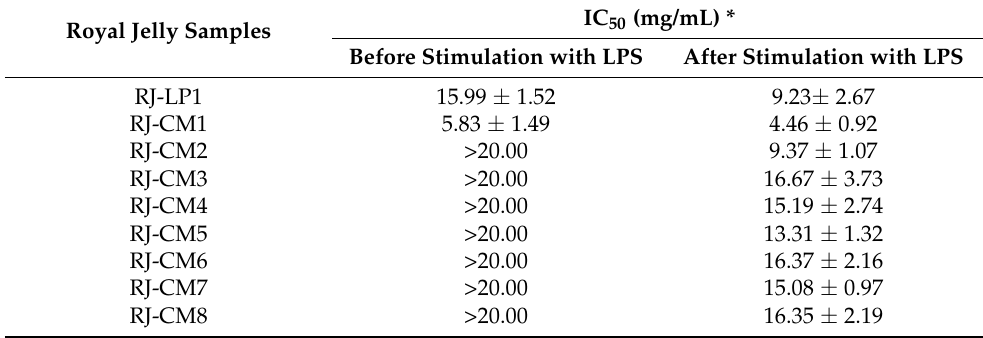
Table 3. IC 50 of royal jelly samples on NO production of RAW264.7 cells.